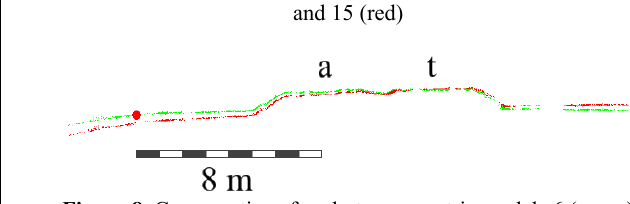
Figure 8. Cross sections for photogrammetric models 6 (green)